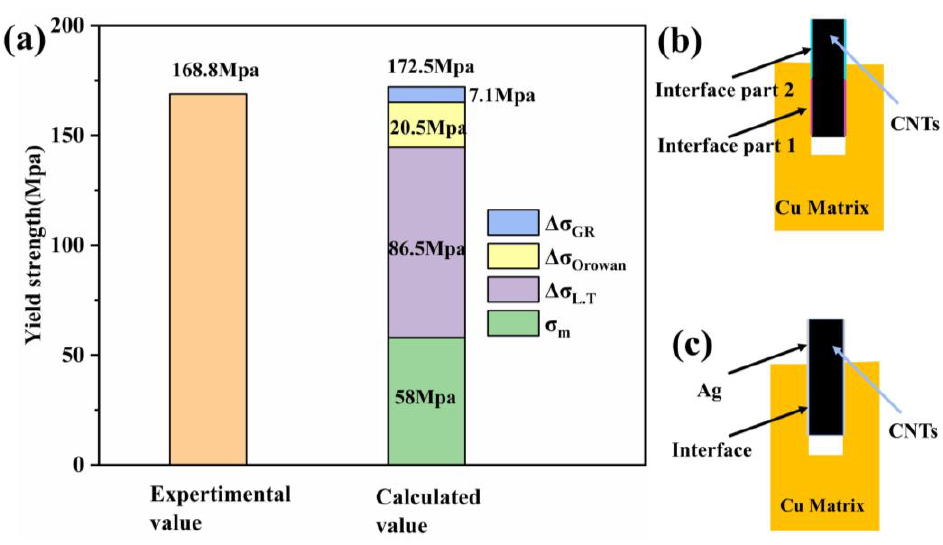
Figure 12. Comparison of calculated yield strength values of composites with their experimental values ( a ); interface analysis of pullout force of CNTs/Cu ( b ) and Ag-CNTs/Cu( c ).